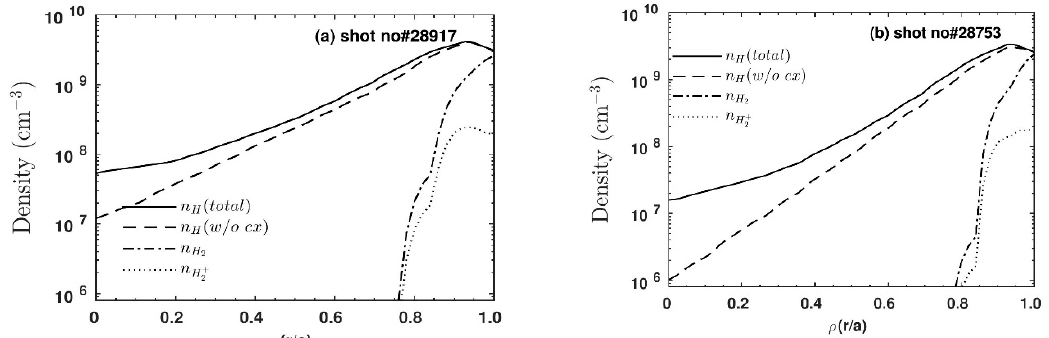
Figure 6. Simulated neutral hydrogen density (n H ), molecular hydrogen density n H , and molecular hydrogen ion density n H 2 + profiles. (a) For the line-averaged electron density 1.46 × 10 13 cm -3 (shot #28917) and (b) for the line-averaged electron density 2.10 × 10 13 cm -3 (shot #28753). The solid curve represents total neutral hydrogen density and the dashed curve represents neutral H density excluding charge-exchange process. The dash-dot and dotted curve represent the density of H 2 and H 2+ ions.